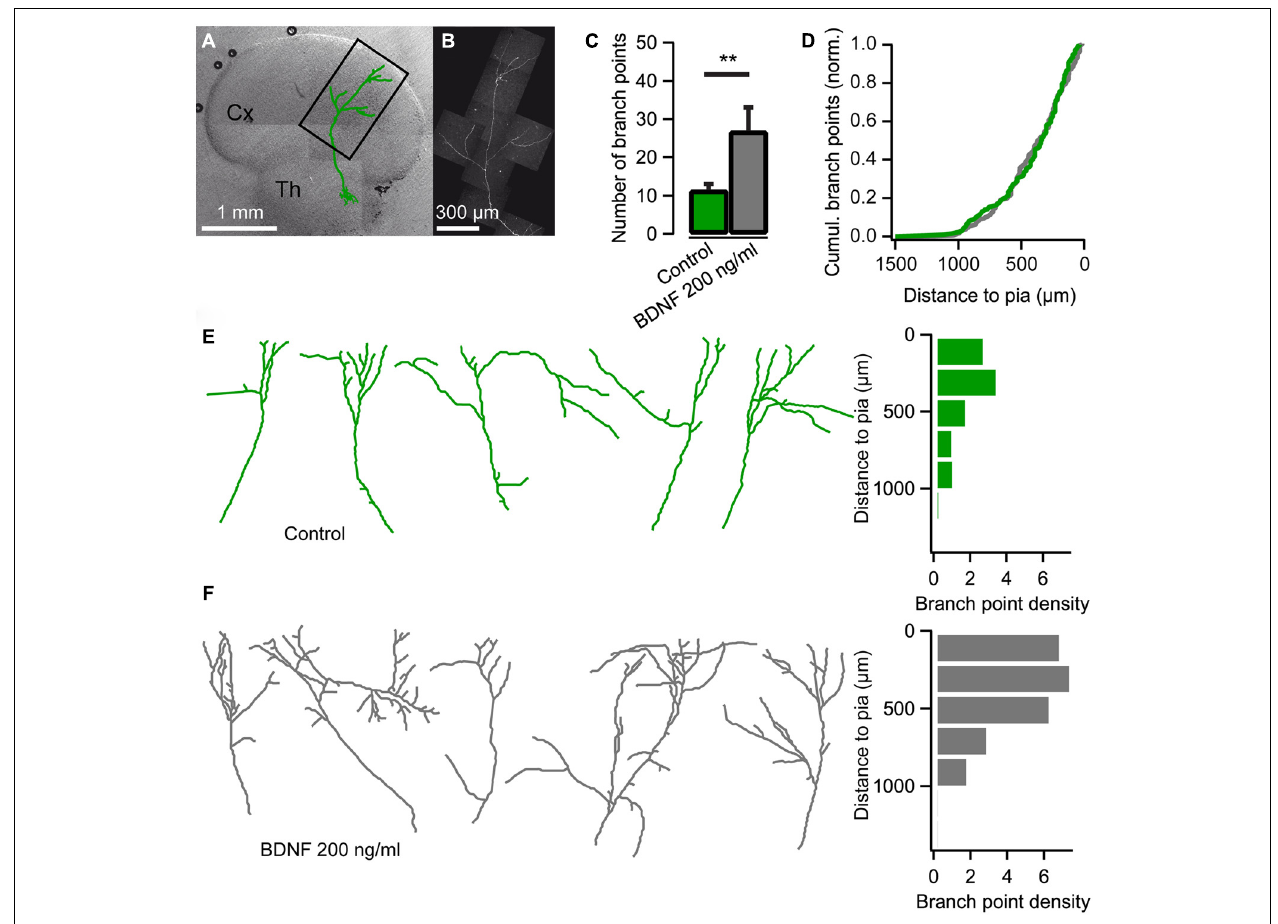
FIGURE 1 | Brain-derived neurotrophic factor (BDNF) promotes axon branching in thalamocortical co-cultures . (A) Reconstruction of a thalamic neuron expressing EYFP (green) superimposed on a differential interference contrast-enhanced micrograph of a thalamocortical co-culture. Cx cerebral cortex; Th thalamus. (B) Confocal micrograph of the axon from the neuron reconstructed in A. (C) Bar diagram for the average number of axonal branch points (the number of times the axon bifurcates) when BDNF is added to the medium. The error bars represent SEM. ** P < 0.01. (D) Cumulative plot of branch-point location with respect to